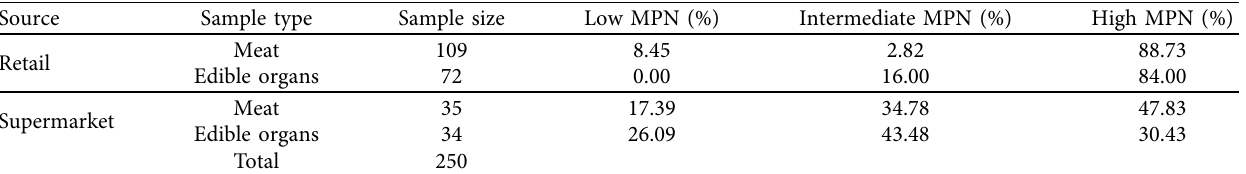
Table 2: Level of E. coli contamination in chicken meat and edible organs sold at retail shops and supermarkets in the Kurunegala district. Source